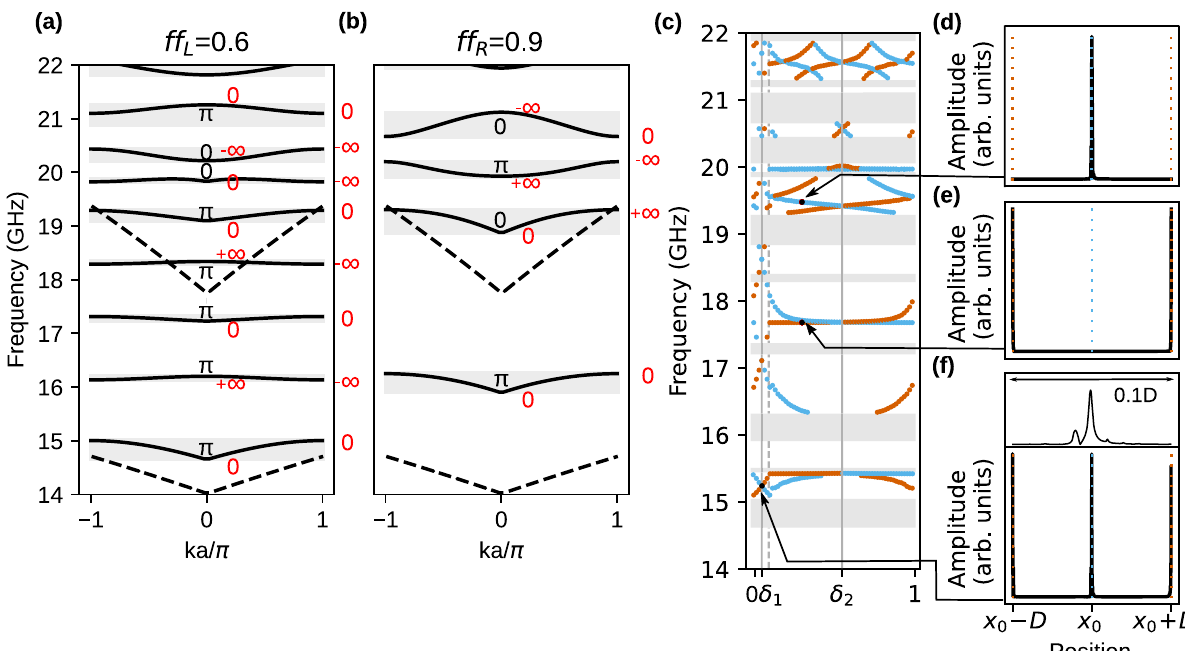
Figure 6. ( a , b ) The dipolar-exchange SW dispersion relations for two MCs which differ only in filing fractions: 0.6 , ( b ) ff R 0.9 . The spectrum for ff 0.9 is shifted up in the frequency scale due to dipolar ( a ) ff L = = = interaction, and the successive gaps in both spectra do not match each other. The forbidden ranges for interfaced 0.6 and ff R 0.9 ) can originate from overlapping of various frequency gaps in both 1D MCs—see MCs ( ff L = = Fig. 5. The values: 0 and π are the Zak phases of the bands, whereas: 0 and (red color) stand for logarithmic ∞ derivatives on the edges of bad gaps. Dashed lines represent dispersion relation for a uniform system made from Py (branch starts at 14GHz) and made from Co (branch starts at 17.5 GHz). ( c ) The dipolar-exchange 0.6 and ff R 0.9 . The spectrum of SW SW interface modes localized on the interface of two 1D MCs of ff L = = interface modes is shown in dependence on the surface parameter δ . We use the same conventions to mark the 1 ff frequencies and localization of the SW interface modes as in Fig. 3d. The gray dashed line denotes δ = − where the Py|Co interface is on the left edge of the unit cell. ( d – f ) The profiles of the SW interface modes in x 0 is presented above ( f ). common (from both 1D MCs) forbidden frequency ranges. The close-up at the x = The SWs decay exponentially in Co strips and have one oscillation per Py lowest oscillatory solution in the Co strips. In the first band, we observe in Co the evanescent excitation forced by the magnetization dynamics in Py. This consideration is supported by spatial profiles of the modes presented in Supplementary Information, Section 4. It is worth noting that the lowest mode in Co can be also identified by 0 . the non-zero group velocity, characteristic of dipolar dynamical coupling in the limit k → The spectrum of considered 1D MC’s is very rich and is dramatically modified with the change of the filling fraction—the bands’ positions and their separations (width of the gaps) vary significantly with ff . Unlike the system with exchange interaction only, the positions of corresponding band gaps (i.e., the band of the same index 0.9 is located in the frequency range corresponding to n ) are different. For example, the first band gap for ff R = 0.6 . The bands are relatively narrow which proves that we are operating in second and third band gaps for ff L = crossover dipolar-exchange regime. The flat dispersion branches in Fig. 6a–c means the low value of the group velocity for SW. δ 1 ). The values were determined In Fig. 6a, b, we marked the Zak phases for centrosymmetric unit cells ( δ = by the inspection of the profiles of the Bloch functions at the edges of the bands (see Fig. 2e, f in Supplementary Information). The sequences of Zak phases allows determining the sign of logarithmic derivatives of Bloch function, ρ , in frequency gaps for MCs at left and right side of the interface. The values of ρ at edges of bands are marked in Fig. 6a, b with red color. The careful inspection of the sign of ρ in common frequency gaps of both MCs (marked as white areas in Fig. 6a, b) allows indicating three common gaps in which the signs of ρ are opposite: gap below 1st band, gap around 18.5 GHz and tiny gap, slightly above 21 GHz. In these gaps, we did not find numerically any interface δ 1 . Concluding, analysis of logarithmic modes: Figure 6c does not present solution at these frequencies for δ = derivative for dipolar-exchange waves is also valid tool to describe the existence criteria for interface modes. This system posses some peculiarities. Due to disturbing the typical sequence of dispersion branches, loga- 0.9 first band gap ρ is equal to 0 rithmic derivative can take the same values on the edges of band gaps. For ff R = on both of the edges, and in second gap is equal to . We were also not able to plot the logarithmic derivatives −∞ of Bloch functions, as we did for exchange waves in Supplementary Information, Section 2. It is related to the